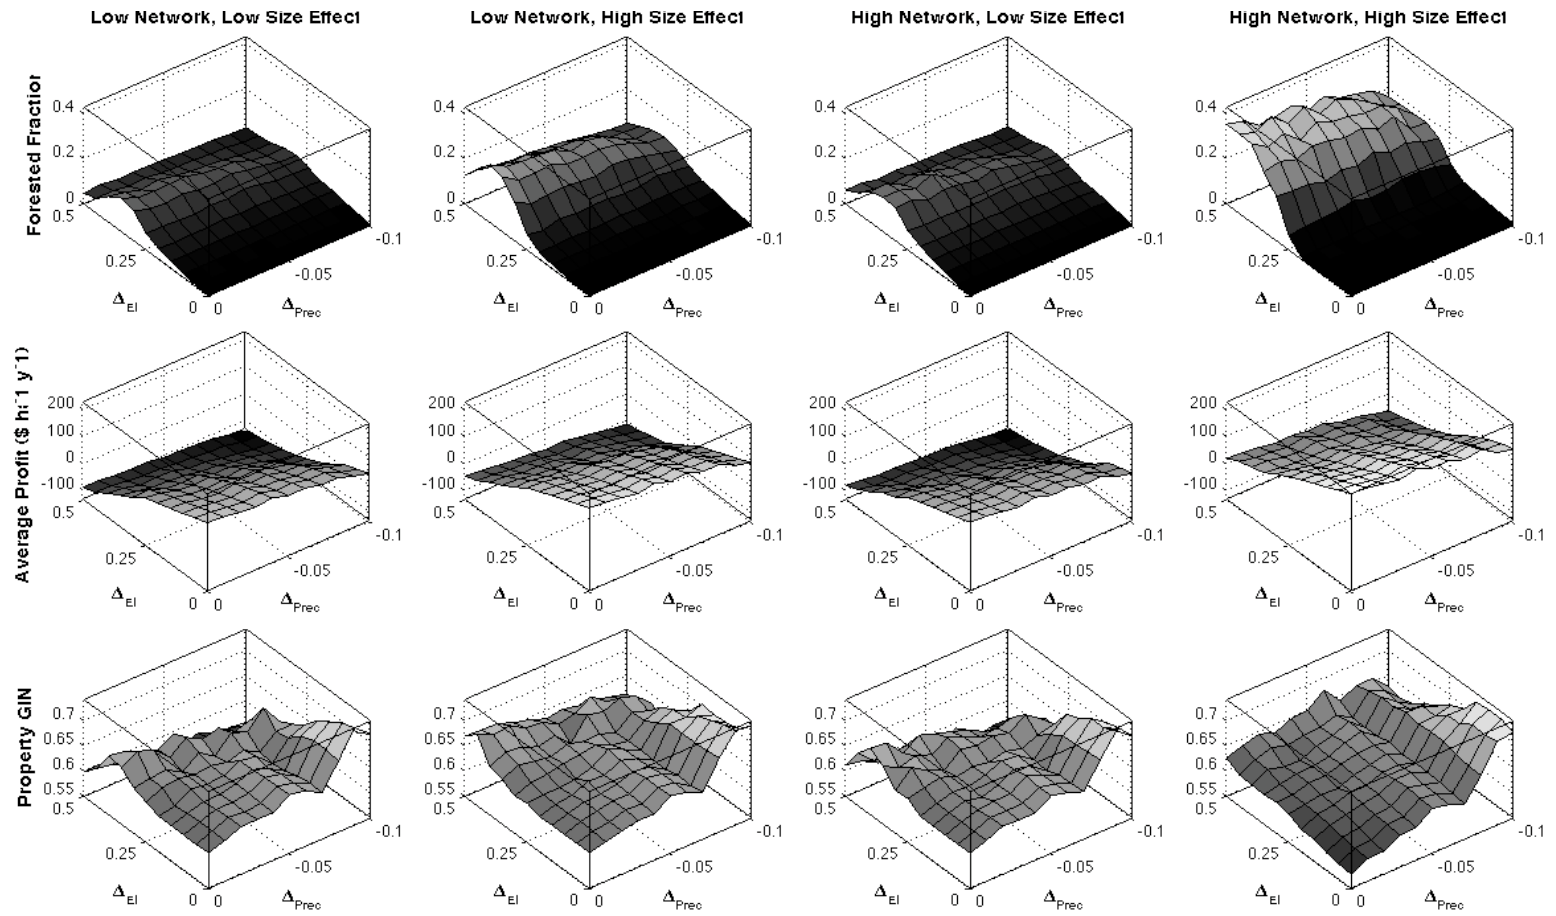
Figure A5.1: Response surfaces for Policy Scenario 1 – Sensitivity to change in expected income Δ EI and in precipitation Δ Prec , non­tiered environmental licensing. Surfaces in row 1 show average forested fraction across the landscape; row 2 shows average profit per hectare of property per year; row 3 shows the level of land aggregation measured by the property GINI coefficient. Each column represents a different scenario of rancher